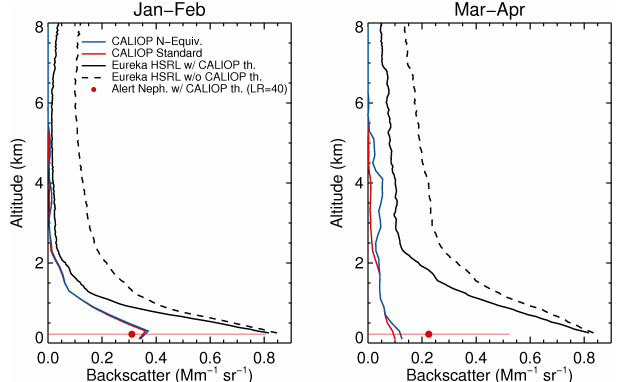
Fig. 8. Vertical profiles of 180 ◦ backscatter observed by the ground- based HSRL at Eureka, Nunavut, Canada (80.0 ◦ N, 86.0 ◦ W) for January–February (left panel) and March–April (right panel) 2007– 2009. The HSRL backscatter profiles with (solid black line) and without (dashed black line) the CALIOP nighttime threshold ap- plied are compared to the CALIOP nighttime-equivalent backscat- ter (blue line) and standard backscatter (red line). The median aerosol backscatter measured at the nearby station of Alert is ob- tained by dividing the measured extinction by a lidar ratio of 40sr, and is shown with and without the CALIOP